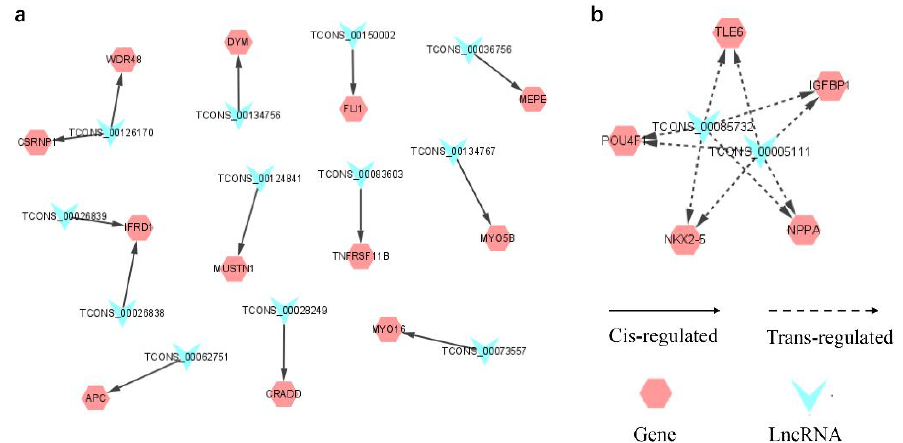
Figure 5. LncRNA-target gene network. The cis-target ( a ) and trans-target ( b ) networks related to muscle development-related GO terms. The V and hexagon nodes represent the DE lncRNAs and putative targeted genes, respectively. Letter abbreviations represent an abbreviated version of the gene name. Solid arrows indicate interactions between the DE lncRNAs and putative cis-target genes, while dashed arrows indicate putative